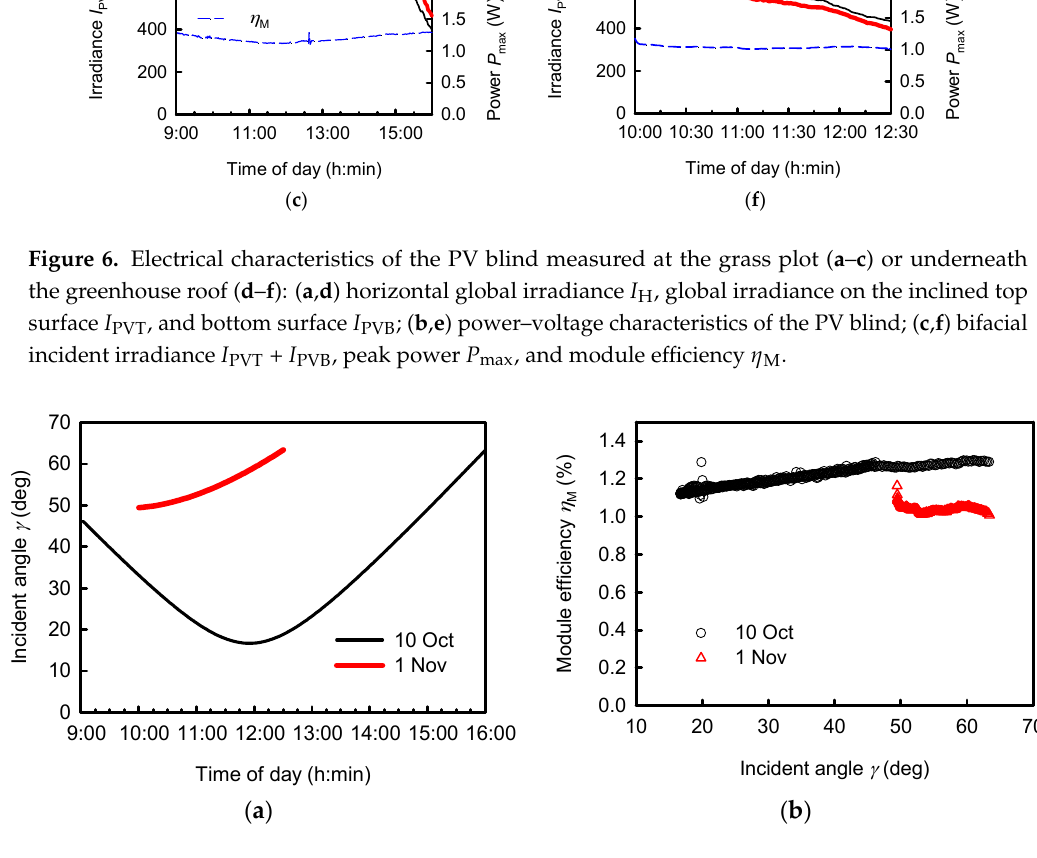
Figure 7. Module efficiency η M with respect to the incident angle γ of direct sunlight: ( a ) angle γ on 10 October at the field plot and on 1 November in the greenhouse; ( b ) η M with respect to γ .